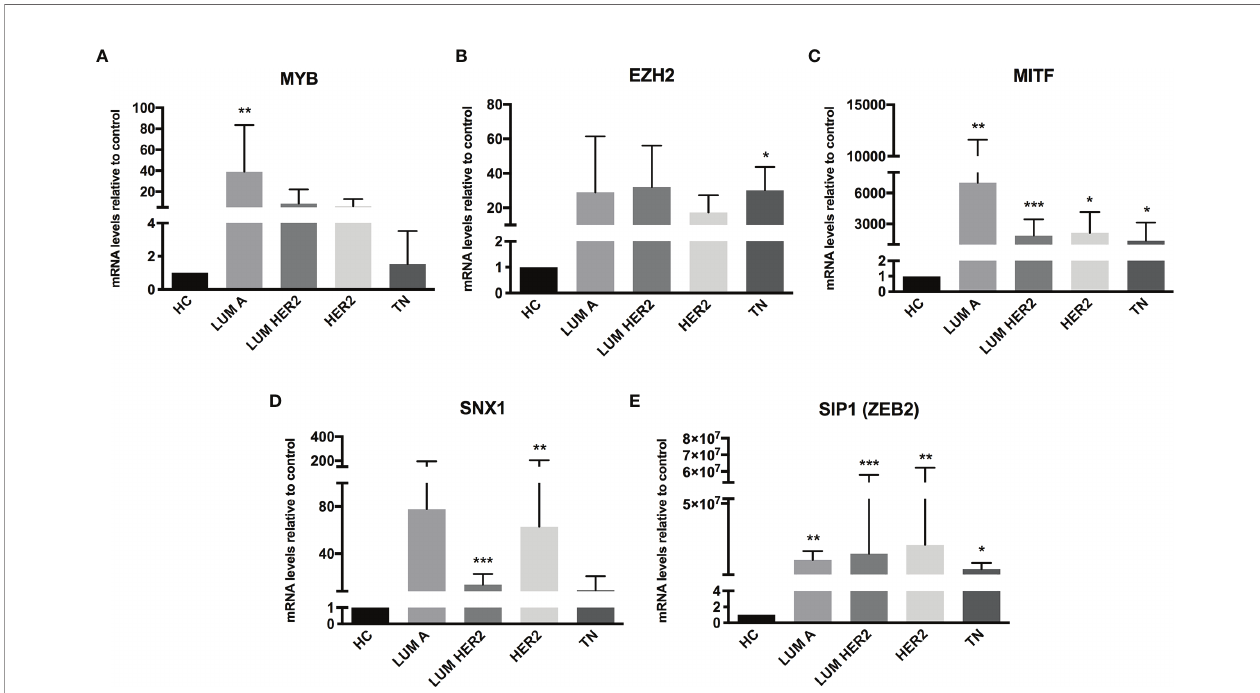
FIGURE 2 | Putative miRNA targets are differentially expressed in BC patients. RT-qPCR analysis of miRNA targets in BC patients. The mRNA level of (A) MYB , (B) EZH2 , (C) MITF , (D) SNX1 and (E) SIP1 (ZEB2) was assessed by raw expression values normalized to GAPDH expression. Healthy donors were used as healthy controls (HC n = 5). Quanti fi cation was performed by the DD CT method. Statistical differences are related to the HC group (LUM A n = 5; LUM HER2 n = 12; HER2 n = 7; TN n = 4). HC, Healthy Control; TN – Basal. *p < 0.05, **p < 0.01 and ***p <